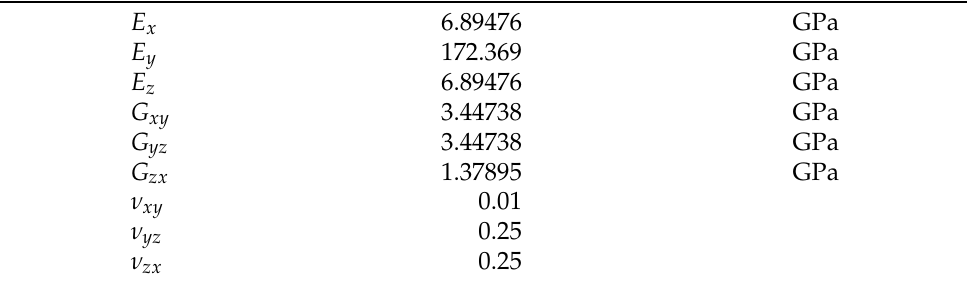
Table 3. Base engineering elastic constants for Example 1.